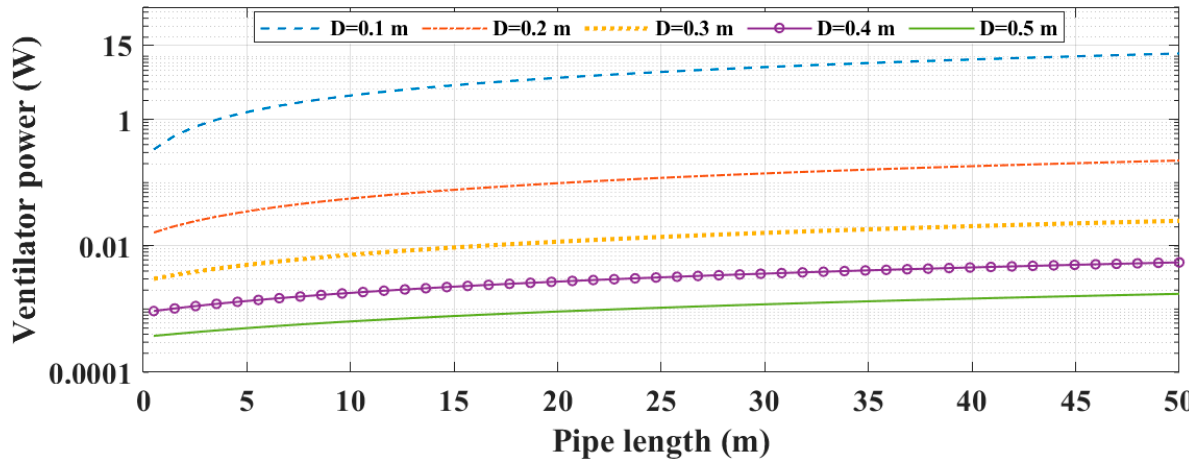
Figure 11. Ventilator power needed for the EAHE system as a function of pipe length and diameter.